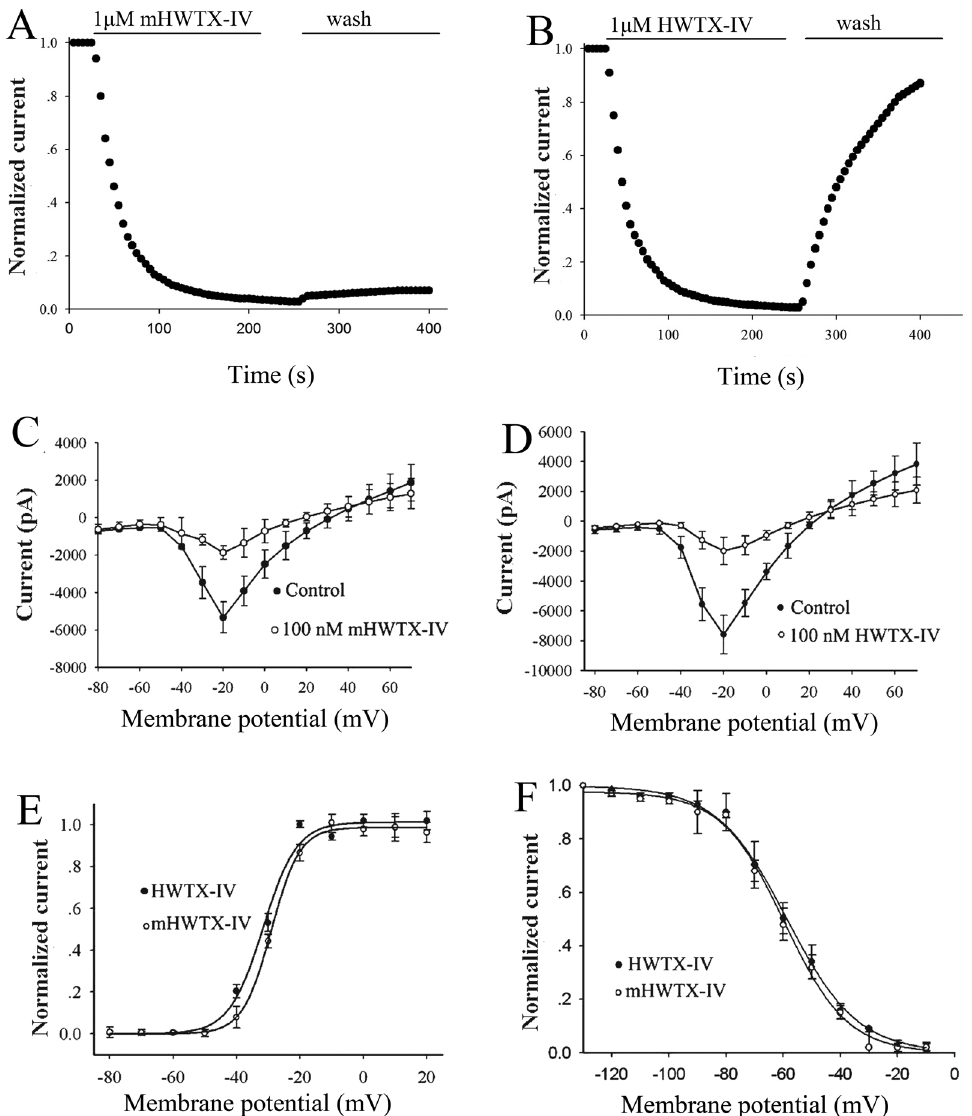
Figure 6. Effects of HWTX-IV and mHWTX-IV on the kinetics of TTX-S sodium channels in rat DRG neurons. Time course for block of TTX-S currents and reversal of block by mHWTX-IV (A) and HWTX-IV (B). Current-voltage (I–V) relationships of sodium currents before and after adding 100 nM mHWTX-IV (AC), HWTX-IV (BD). HWTX-IV and mHWTX-IV showed no obvious difference on the steady-state activation (CE) and inactivation (DF). Control for each panel means no toxin treatment. Every data point (mean 6 S.E.) was obtained from five separate experimental cells. The data points for both activation and inactivation kinetics were well fitted with the Boltzmann equation.